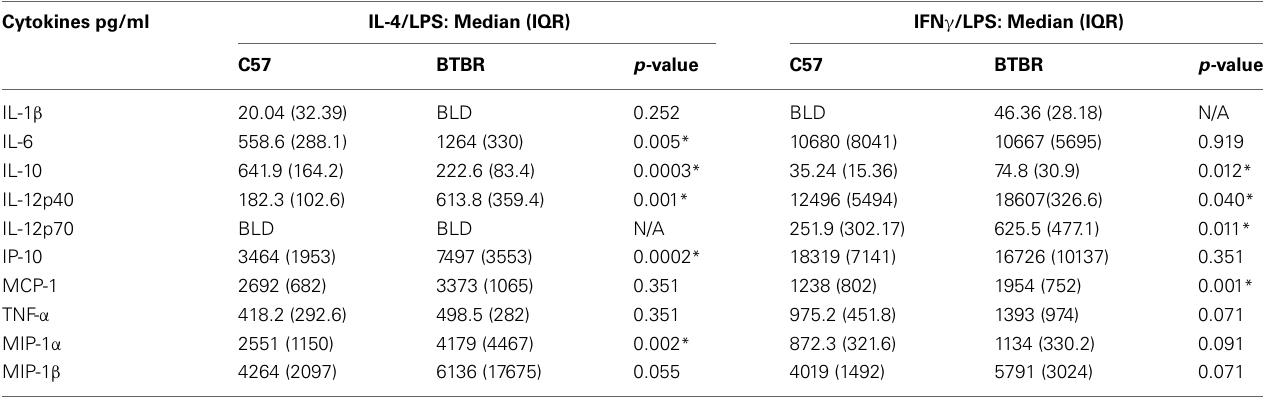
Median cytokine measurements and interquartile ranges (IQR) in pg/ml. All p-values were calculated by two-tailed Mann Whitney U-test.